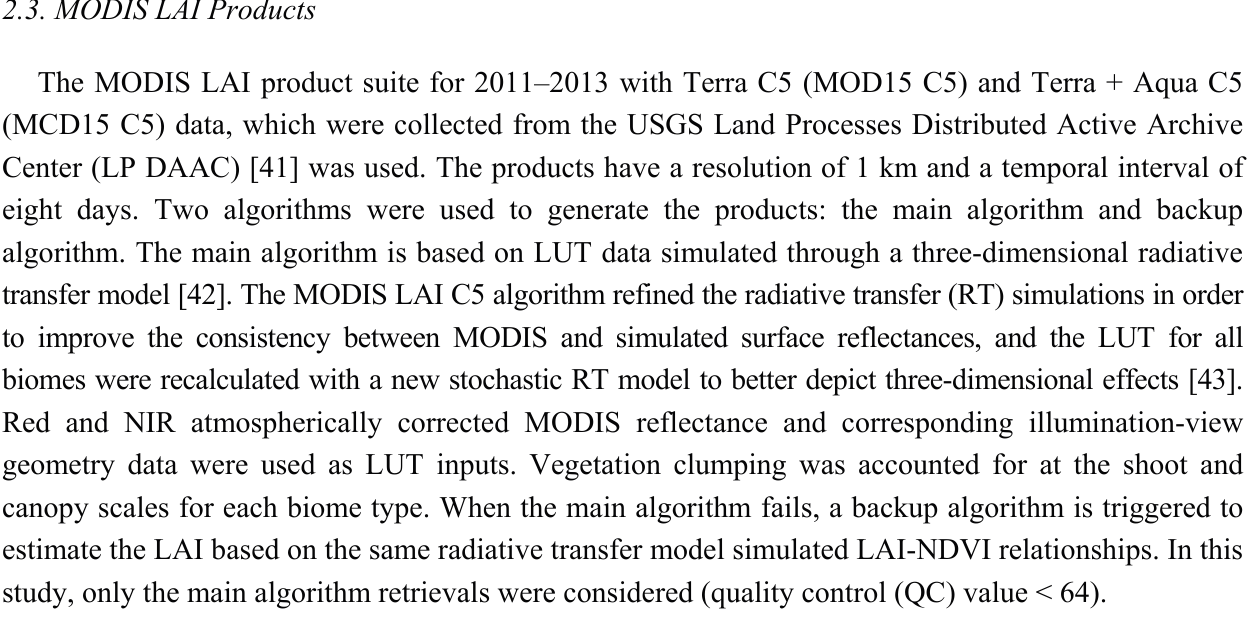
ρ and ρ represent the hemispherical albedos of soil v g